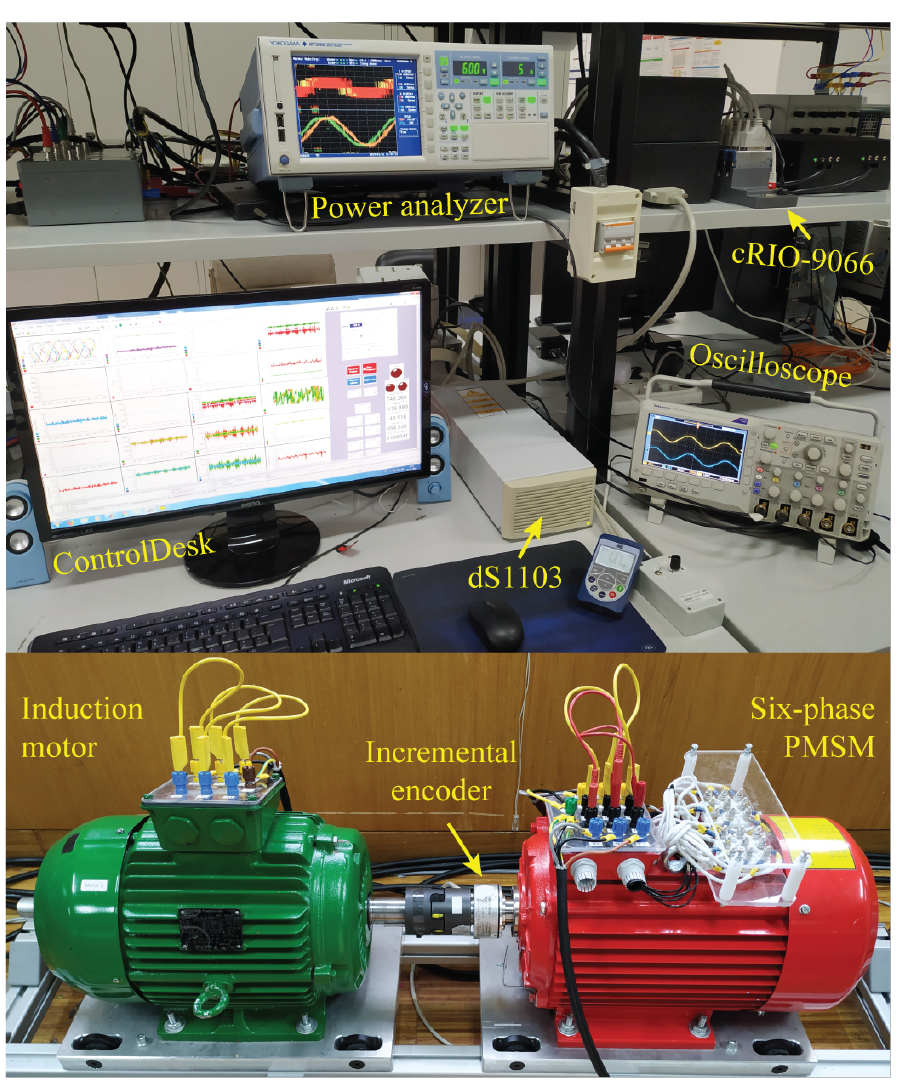
Figure 8. Experimental